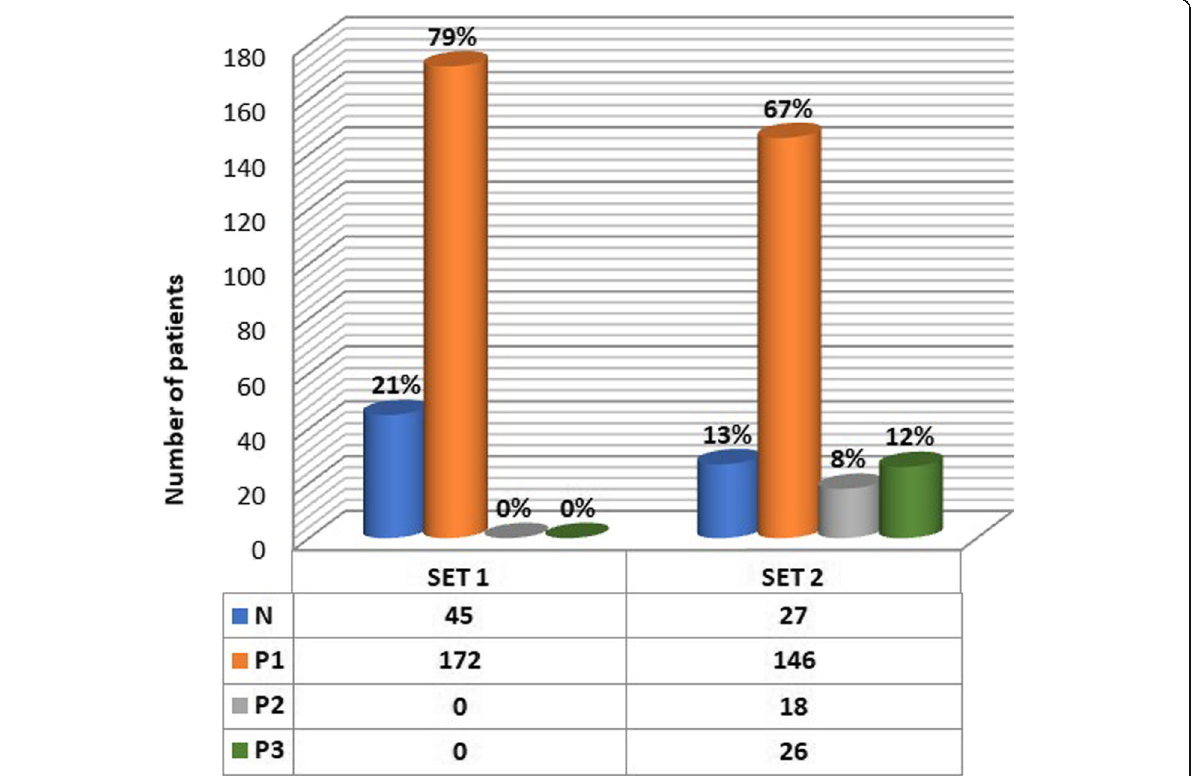
Fig. 1 A graph presentation of MRI findings as reported using set 1 (routine MR protocol images) and set 2 (routine protocol MR images and additional coronal STIR images). N normal MR images of the lumbar spine, P1 positive spinal abnormalities, P2 positive extra-spinal abnormalities and P3 spinal and extra-spinal abnormalities. The percentage of normal studies (blue column) has been downgraded from 21% on set 1 to 13% on set 2, on the expense of increase in the number of extra-spinal abnormalities (gray and green columns) detected after adding coronal STIR